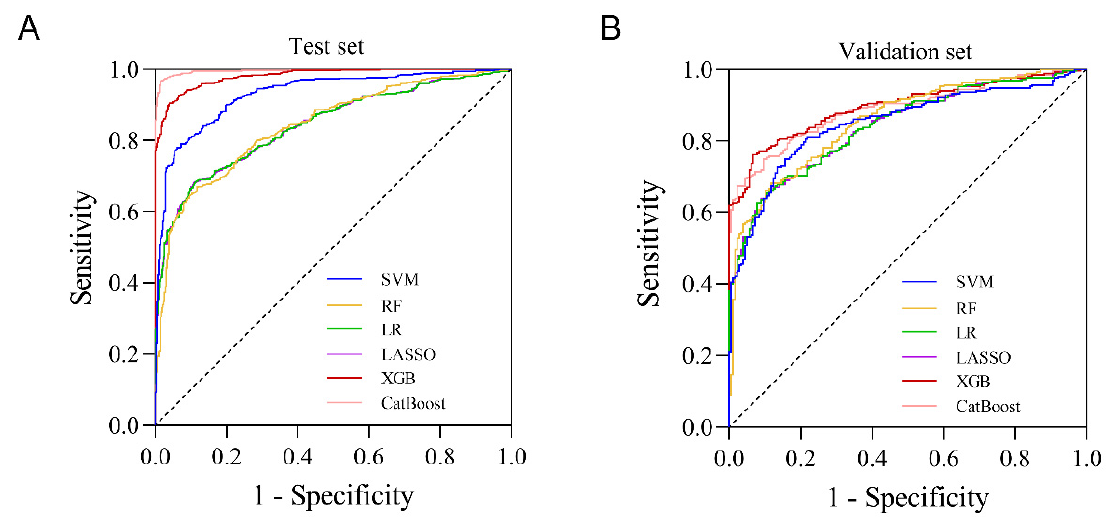
Figure 3. ROC curve of six ML models for predicting grade ≥ 2 CIM. ( A ) In the test set; ( B ) in the validation set. SVM: support vector machine; RF: random forest; LR: logistic regression; LASSO: least absolute shrinkage and selection operator; XGB: extreme gradient boosting. Table 6. Evaluation of fitting effect of each model.